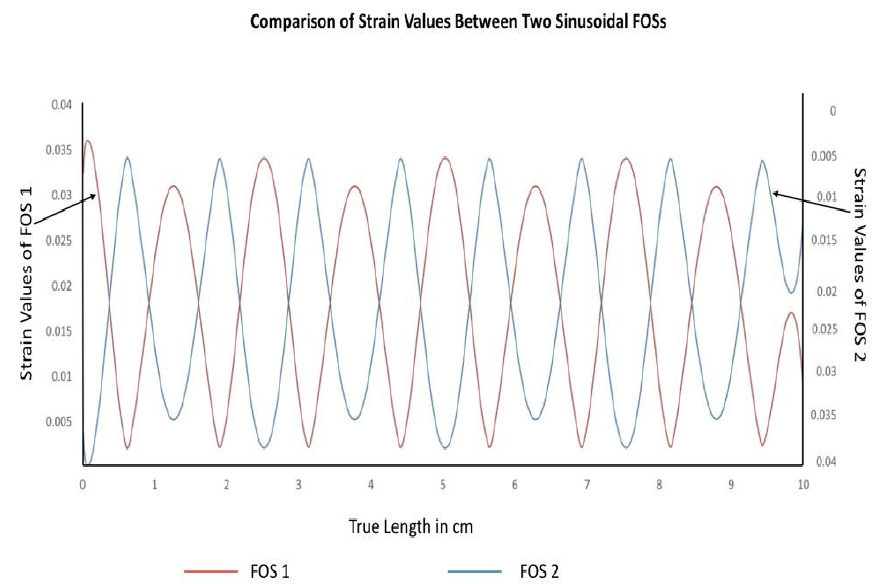
Figure 14. Comparison between strain parameter sensed with dual sinusoidal alignment.